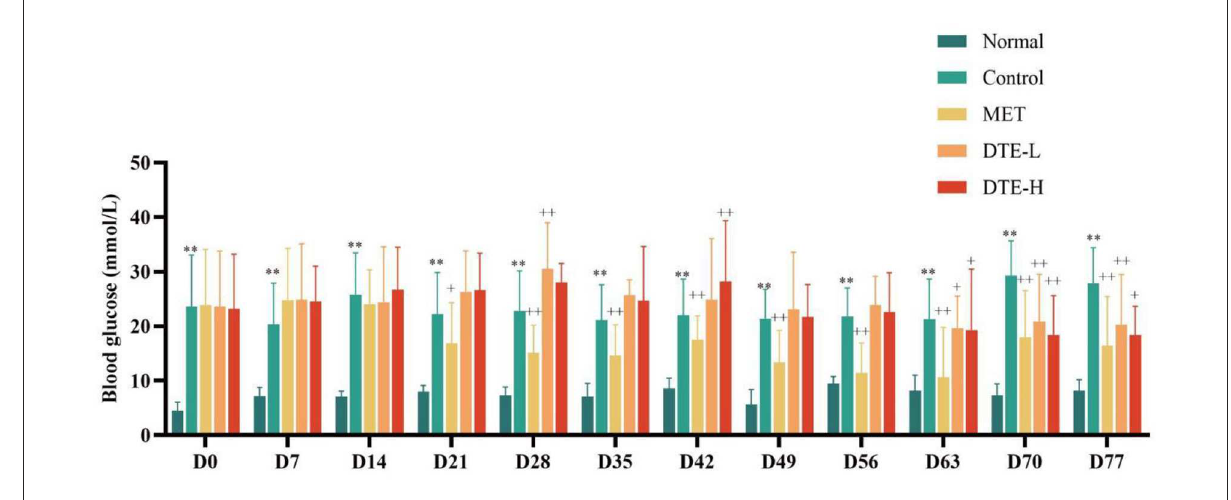
FIGURE1 The effect of DTE on fasting blood glucose of db/db diabetic mice. Control, MET, DTE-L, DTE-H vs. Normal, ** p < 0.01; MET, DTE-L, DTE-H vs. Control, + p < 0.05, ++ p < 0.01.